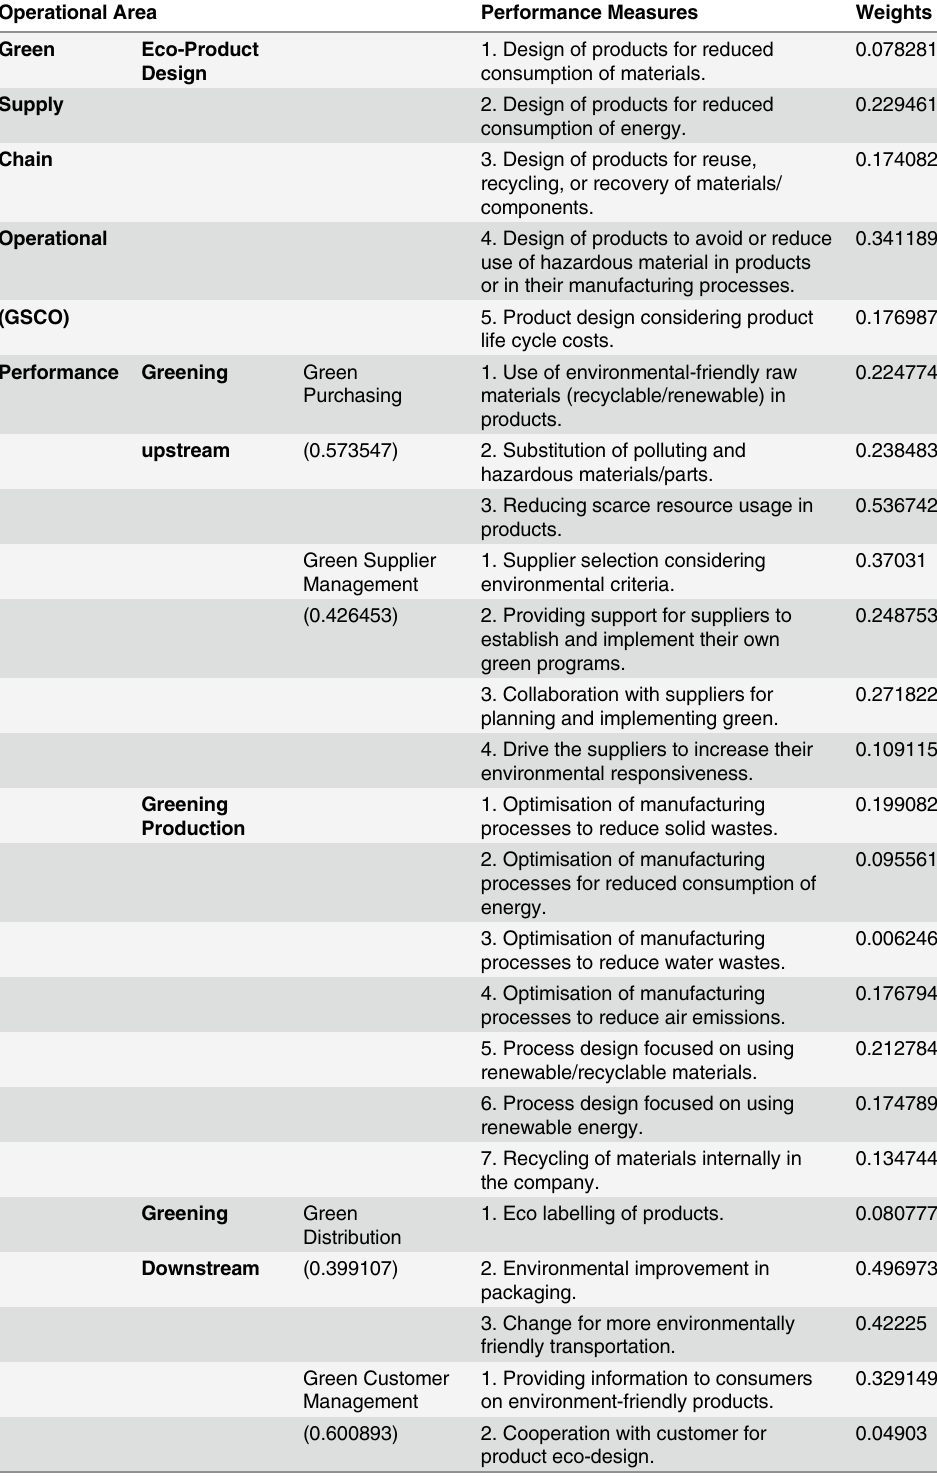
Table 11. Performance measurement indicators and their relative